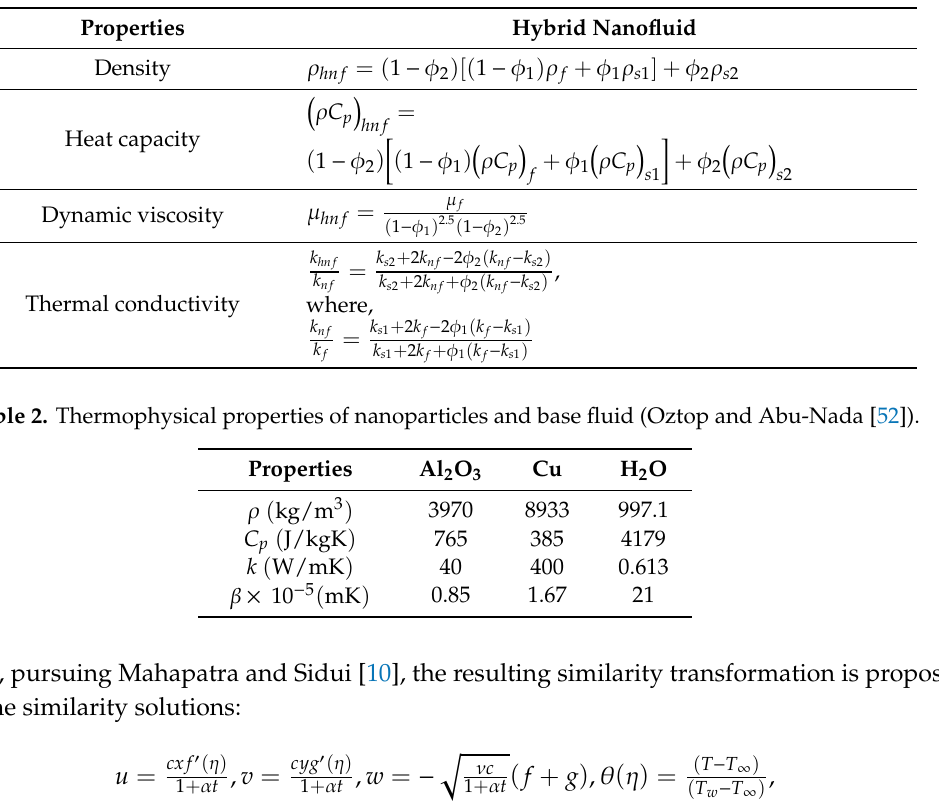
Table 1. Thermophysical properties of hybrid nanofluids (Devi and Devi [41,51]).